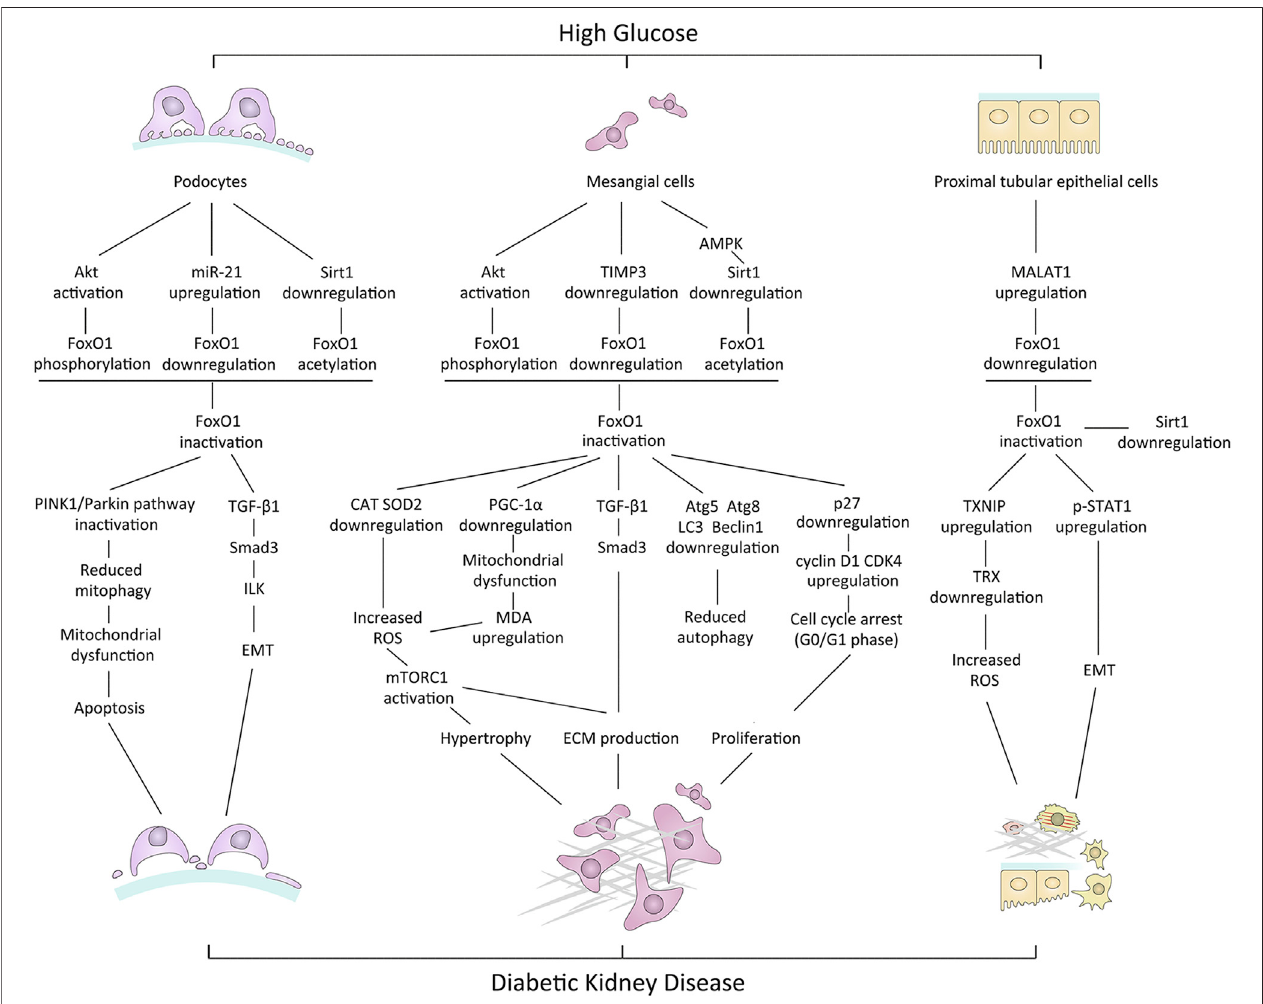
FIGURE 2 | Mechanisms underlying renal cell damage associated with dysregulation of FoxO1 activity in high-glucose conditions. PINK1, PTEN-induced putative kinase 1; TGF- β 1, transforming growth factor-beta1; ILK, integrin-linked kinase; EMT, epithelial-mesenchymal cell transformation; TIMP3, tissue inhibitors of metalloproteinase3; CAT, catalase; SOD, superoxide dismutase; MDA, malondialdehyde; ROS, reactive oxygen species; ECM, extracellular matrix; TXNIP, thioredoxin- interacting protein; TRX, thioredoxin; p-STAT1, phosphorylated STAT1.